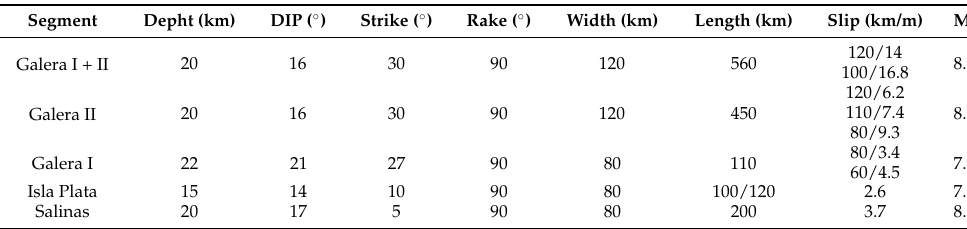
Figure 1. Location maps and seismotectonic setting. ( A ) Regional view of tectonic segments modified from IOC [57], where the stars indicate the epicenters of large subduction events occurred in the coastal zone of Ecuador within the last 120 years. ( B ) Record and extension of the ESI-2007 macroseismic Intensity of the 2016 Pedernales earthquake (M7.8). Table 1. List of the parameters of the tectonic segments along the coast of Ecuador, as modified from the IOC